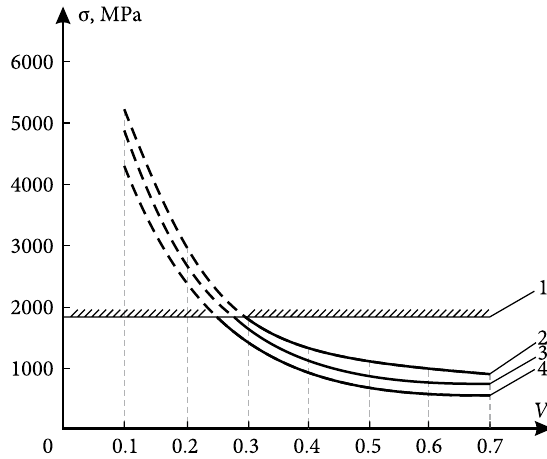
Fig. 7. Evaluation of rational volume fraction of steel (at constant vertical load): 1 – limit of strength of steel; 2 – dependence for variant of hybrid composite cable on the basis of steel, GFRP and CFRP; 3 – dependence for variant of hybrid composite cable on the basis of steel, Vectran and CFRP; 4 – dependence for variant of hybrid composite cable on the basis of steel, GFRP and Vectran; σ – stresses, acting in the steel component of hybrid composite cables after other components disruption; V – volume fraction of steel